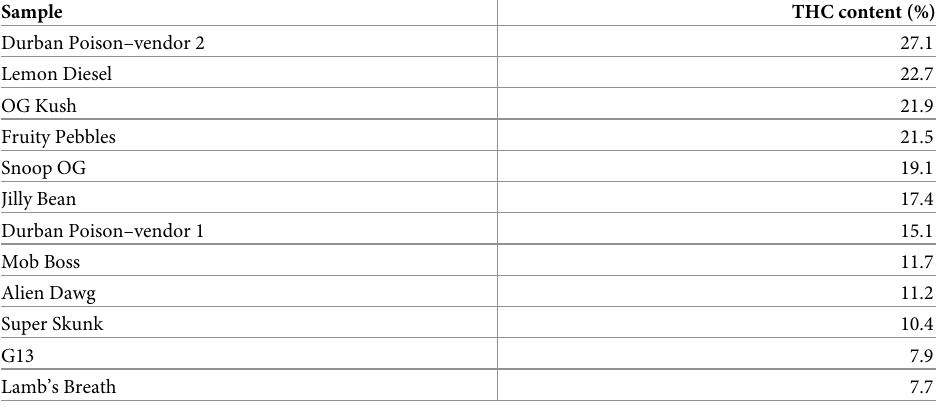
To determine whether perceived potency based on smell varied systematically with actual THC concentration, we calculated the Spearman rank-order coefficient between THC value and mean Potency rating for each strain. Because samples G13-1 and G13-2 were split samples of the same physical material, we measured THC in strain G13 only once. Rather than arbi- trarily pair the THC data with the mean Potency of one sample or the other, we ran the analy- sis twice. We calculated the Spearman correlation coefficient once using the value for G13-1, and again using the value for G13-2. In neither case was perceived potency correlated with measured THC (using G13-1, r = -.021, ns ; using G13-2, r = -.098, ns ; n = 12 in each analysis). s s Thus, while participants perceived large differences in sample potency based on smell, these perceptions do not correspond to the THC content of the samples. Similar analyses showed that neither Interest nor Price were correlated with THC content (S3 Note. Experimental THC content versus Interest and Price). Table 3. Measured THC content of the cannabis samples used in this